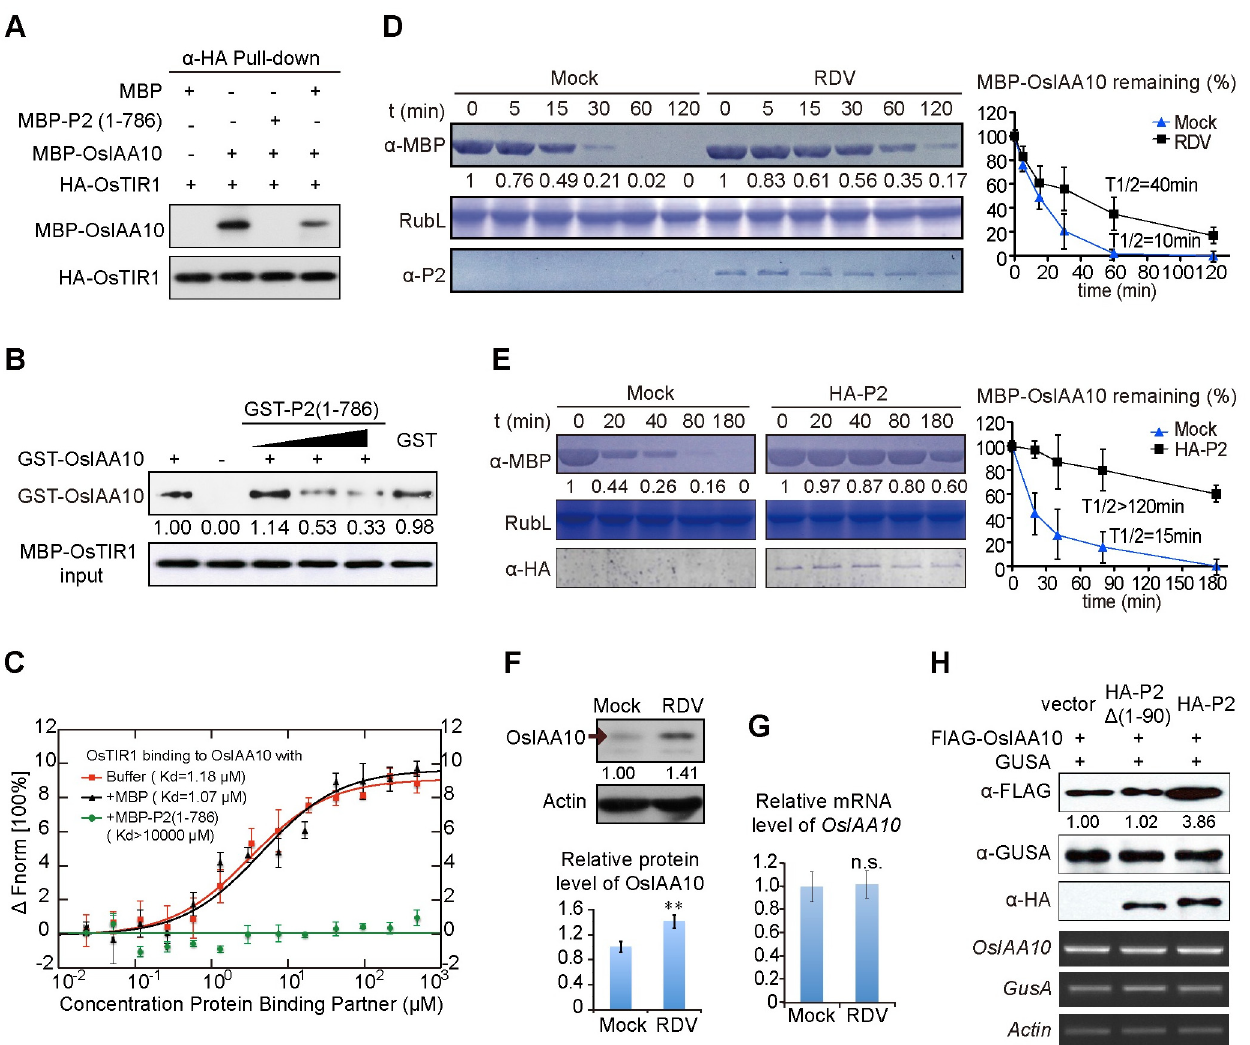
Fig 3. The RDV P2 protein stabilizes OsIAA10 by inhibiting OsIAA10/OsTIR1 interaction. (A) Interaction between MBP-OsIAA10 and HA-OsTIR1 is disrupted by MBP-P2 (1 – 786). MBP-OsIAA10 protein combined with MBP-P2(1 – 786) or MBP was incubated with immobilized HA-OsTIR1. The immunoprecipitated fractions were detected by anti-MBP antibody. HA-OsTIR1 input is shown in the lower panel. (B) In vitro interaction between GST-OsIAA10 and MBP-OsTIR1 is weakened by GST-P2 (1 – 786) in a dose dependent manner, revealed by pull-down. GST-OsIAA10 protein combined with GST-P2(1 – 786) or GST was incubated with immobilized MBP-OsTIR1. The immunoprecipitated fractions were detected by anti-GST antibody. The gradient indicates increasing amount of GST-P2(1 – 786). MBP-OsTIR1 input is shown in the lower panel. (C) P2 affects dynamic association between OsTIR1 and OsIAA10. Data were collected from microscale thermophoresis (MST) assays as described in Materials and Methods. Experiments repeat for three times and Error bars indicate SD. Fnorm, normalized fluorescence. (D and E) Cell-free degradation assay of MBP-OsIAA10 in mock- or RDV- infected rice extracts (D) or N . benthamiana leaf extracts (E). Mock in (D) indicates healthy rice extracts; Mock in (E), extracts of leaves infiltrated with pWM101 vector as a negative control; HA-P2, extracts of leaves infiltrated with pWM101-HAS2 that express HA-P2. Rubisco large protein (RuL) was used as a loading control of total plant protein. On the right was a normalized plot for the degradation of MBP-OsIAA10 of the left. The details for quantification and normalization are described in Materials and Methods. Error bars indicate SD. (F) Western blot showing OsIAA10 protein levels in mock and RDV-infected WT rice plants. Actin was used as a loading control. And the Histogram underneath represents the relative protein level. Experiments repeat for three times and Error bars indicate SD. Significant differences were indicated ( ** P < 0.01) based on Student ’ s t -test. (G) qPCR showing OsIAA10 transcript levels, respectively, in mock and RDV-infected WT rice plants. OsEF1a was used as the reference. Values are mean ± SD (n = 3 biological replicates). n. s. indicates no significant difference based on Student ’ s t -test. (H) Effects of P2 and P2 Δ (1 – 90) on the accumulation of OsIAA10 in N . benthamiana after auxin treatment. The three upper panels show protein levels on Western blots and the three lower panels show mRNA levels revealed by RT-PCR. GusA was expressed and loaded as a reference